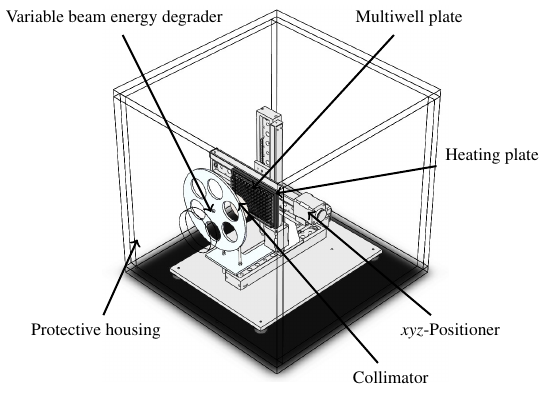
Figure 5. Schematic diagram of the sample handling